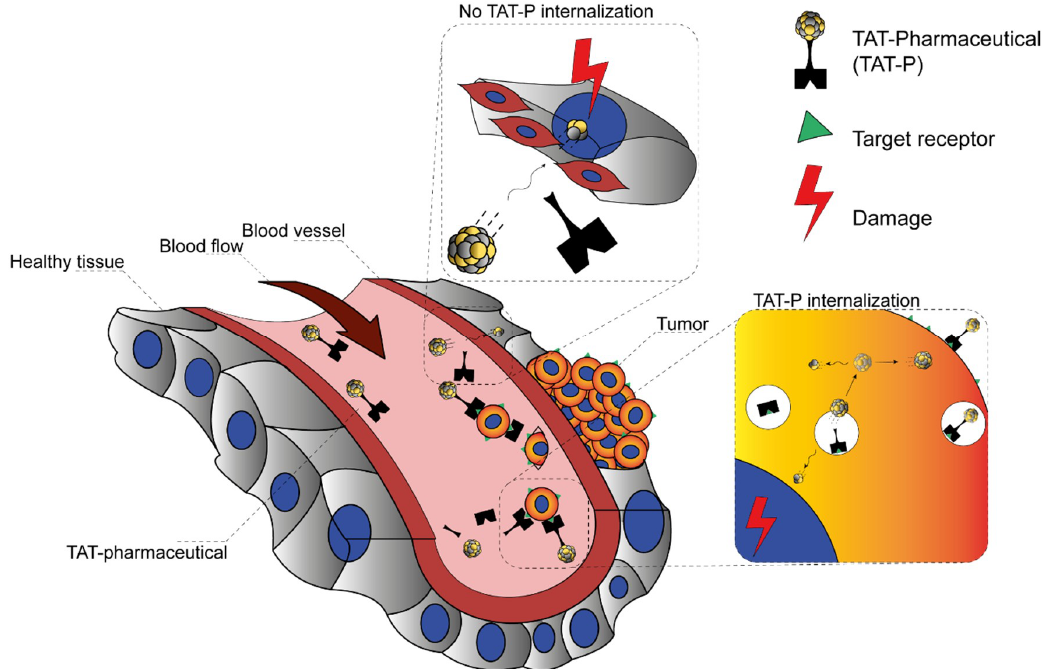
Figure 5. Nuclear recoil effect during α-decay within pharmaceuticals for targeted alpha therapy (TAT-P). Schematic representation of two hypothetical scenarios describing the fate of the recoiling daughter radionuclide that gets released from the chelating moiety of TAT-P in vivo. The upper section labelled “No TAT-P internalization” depicts a daughter radionuclide that is released into the blood stream while causing either unspecific local damage to healthy tissue or travels further with the blood stream and causes analogical damage distantly elsewhere. The lower section labelled “TAT-P internalization” depicts TAT-P that specifically internalizes into the targeted tumor cell. The daughter radionuclide is then released with a high probability inside the tumor cell or to a minor extent might escape the tumor cell and cause damage not only to the target tumor cell but, depending on the travelled distance, to other cells as well.